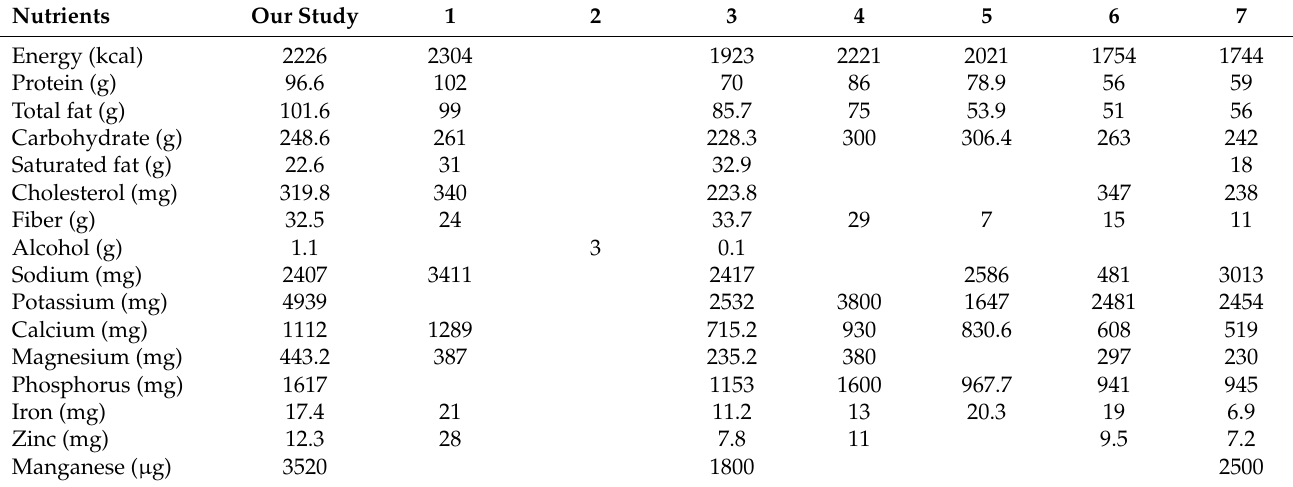
Figure 2. Percentage of the relative difference between the mean of nutrient intakes during pregnancy and the recommended values. Percentage of the relative difference from the mean of nutrient intakes during pregnancy of FFQs compared with dietary reference values established for each nutrient by the European Food Safety Authority (EFSA). Table 5. Comparison of the daily average intake of energy and nutrients based on food frequency questionnaires (FFQ1 and FFQ2) with results obtained by other